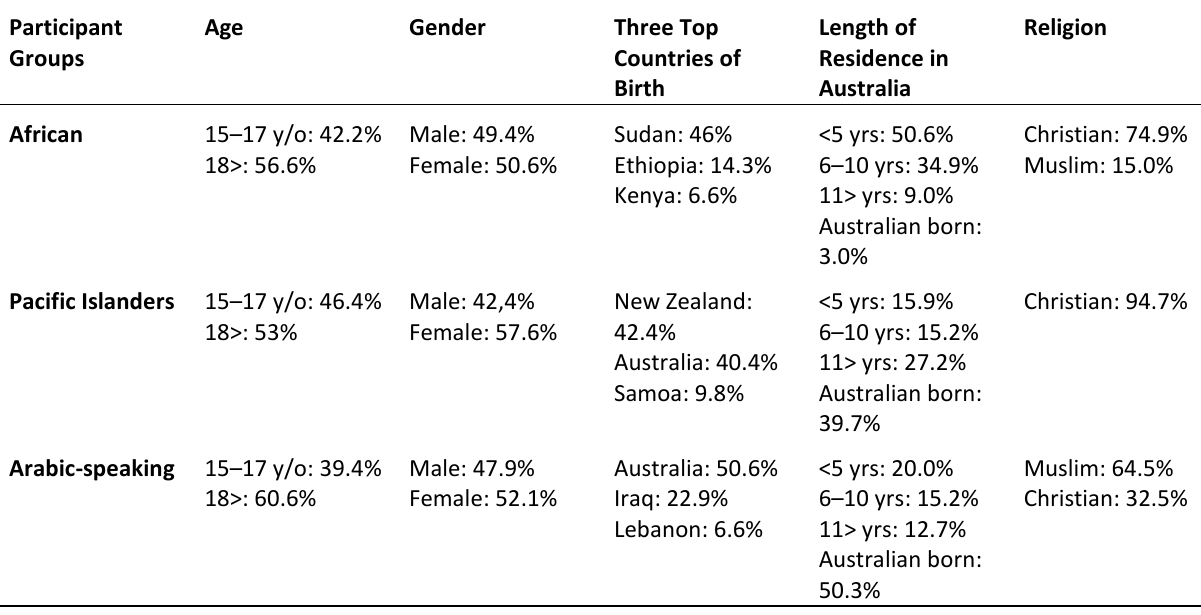
Table 1. Survey Sample at a